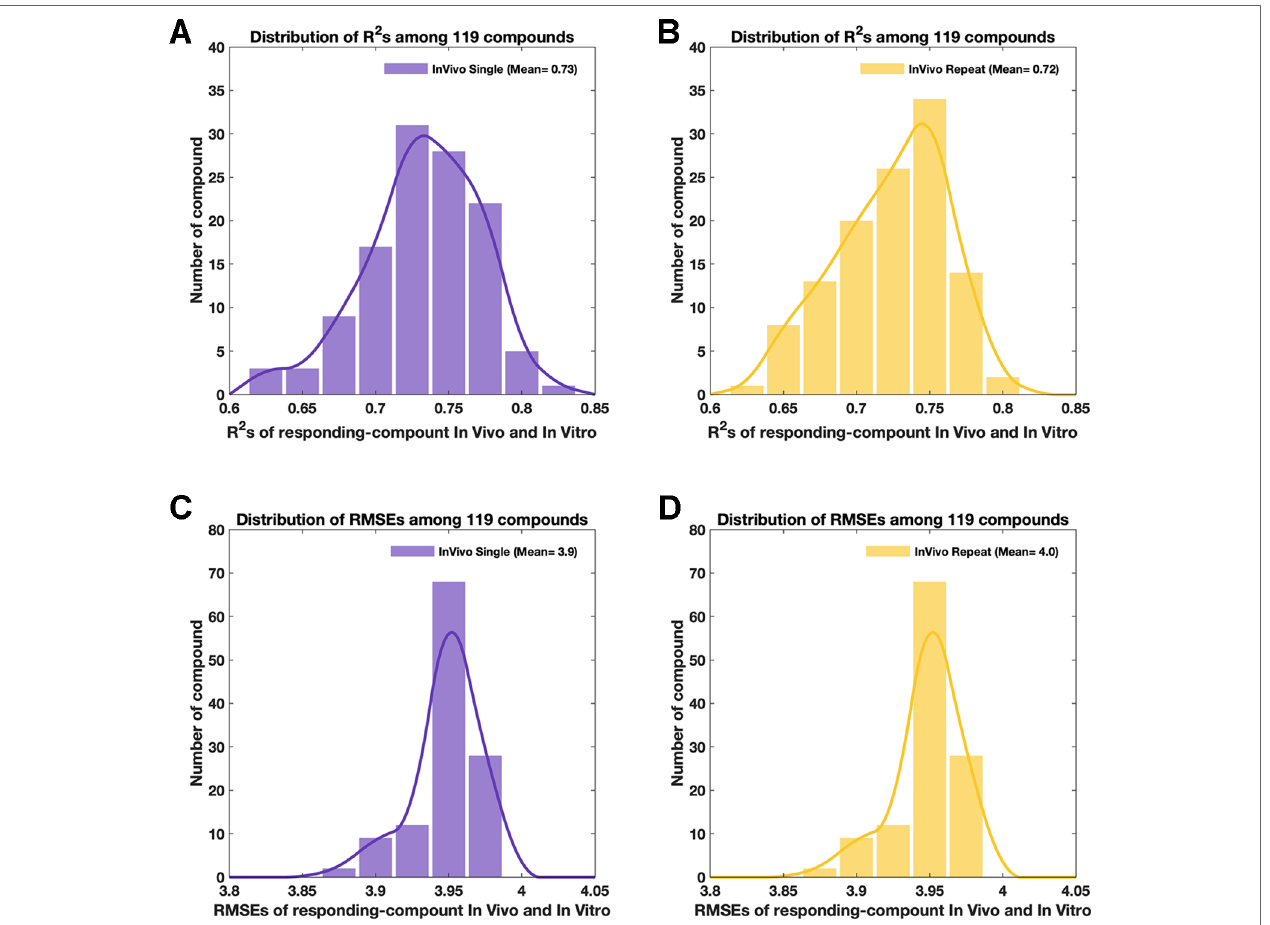
FIGURE 4 | The attributions of simulated in vivo data. Purple color and yellow color in this fi gure always indicate data from the single-dose and repeat-doses systems, respectively. (A and B) The distribution of R 2 among 119 compounds between the original in vivo and the simulated in vivo data for single-dose and repeat-doses data, respectively. (C and D) The distribution of RMSE among 119 compounds between the original in vivo and the simulated in vivo data for single- dose and repeat-doses data,